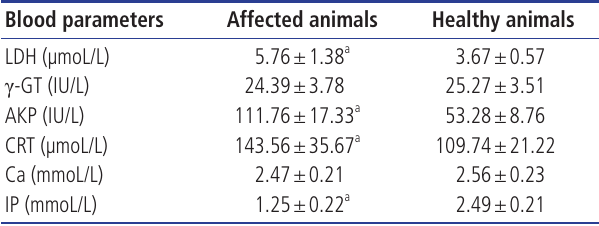
Table 4. Mineral element contents in soil and forage samples Soil Forage Elements